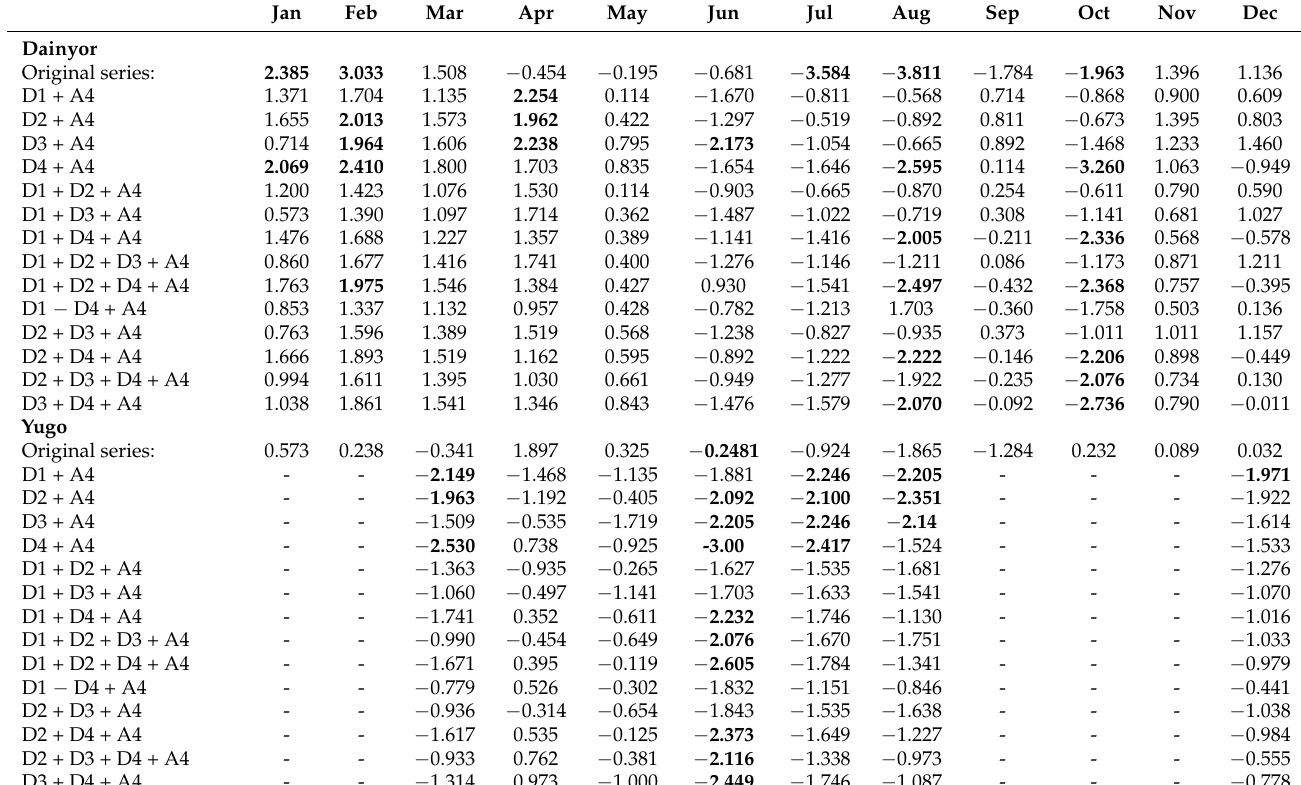
Table 2. Monthly Mann–Kendall (MK) test results with different wavelet decompositions for Dainyor, Yugo, Partab Bridge and Besham Qila (sign of MK statistic indicates trend